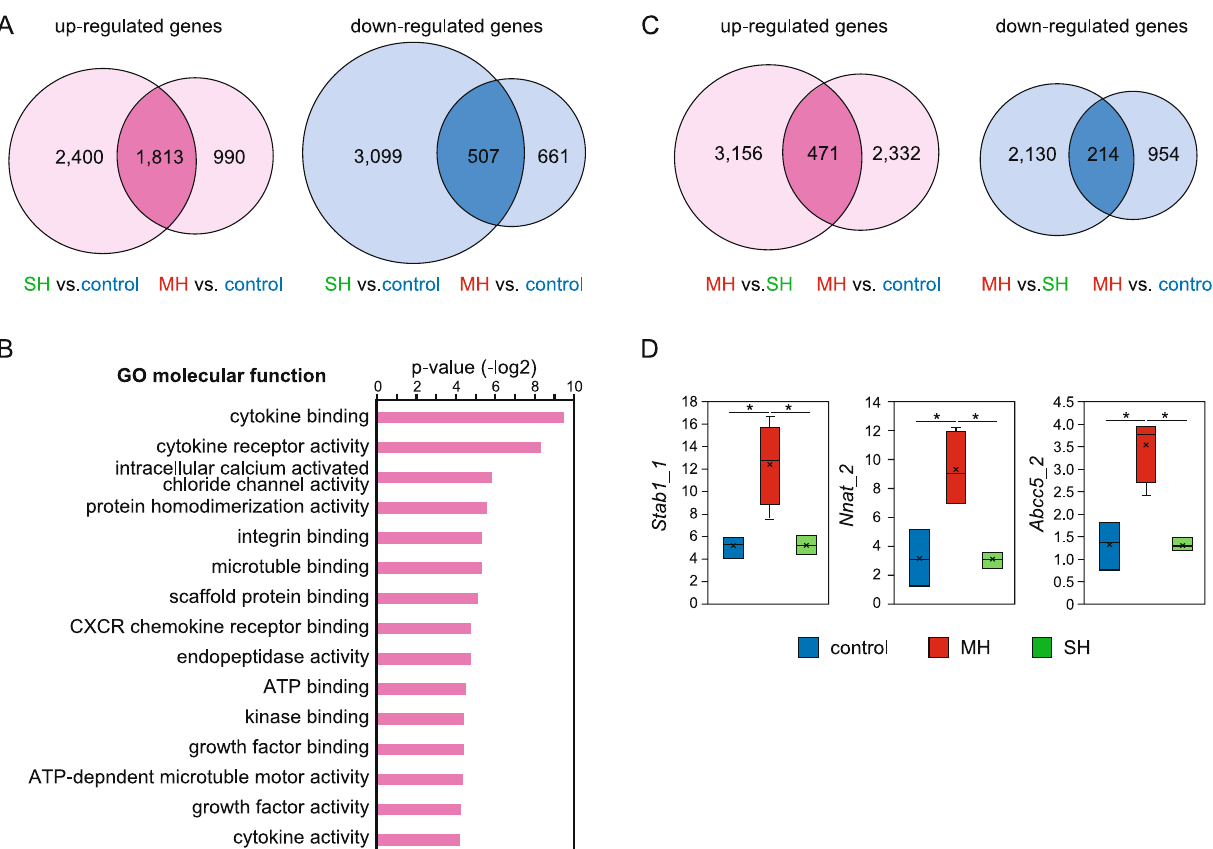
Figure 2. Total gene expression patterns in the three experimental groups. ( A ) Gene expression profiles of urinary bladder tissues from the control, MH, and SH groups using RNA-seq results. Comparison analysis was performed between the SH versus control and MH versus control groups. In total, 1,813 genes exhibited more than twofold increases in mRNA expression in the MH and SH groups compared with the control group, whereas 507 genes were downregulated by at least 50% in the MH and SH groups. ( B ) RNA-seq-based GO analysis of genes upregulated more than twofold in the MH and SH groups compared with the control group (1,813 genes shown as dark pink in Fig. A ). ( C ) Gene expression profiles with comparisons between the MH and SH groups and the MH and control groups. In total, 471 genes exhibited a more than twofold increase in mRNA expression in the MH group compared with the SH and control groups. Additionally, 214 genes showed a more than twofold decrease in expression in the MH group compared with the other two groups. ( D ) Expression pattern of each gene showing marked changes in mRNA expression in the MH group compared with the SH and control groups. The box represents the 25th to 75th percentile interval, and the line represents the median. The cross mark represents average. Top or bottom of bar extending from the box represents the maximum or minimum, respectively. * P <